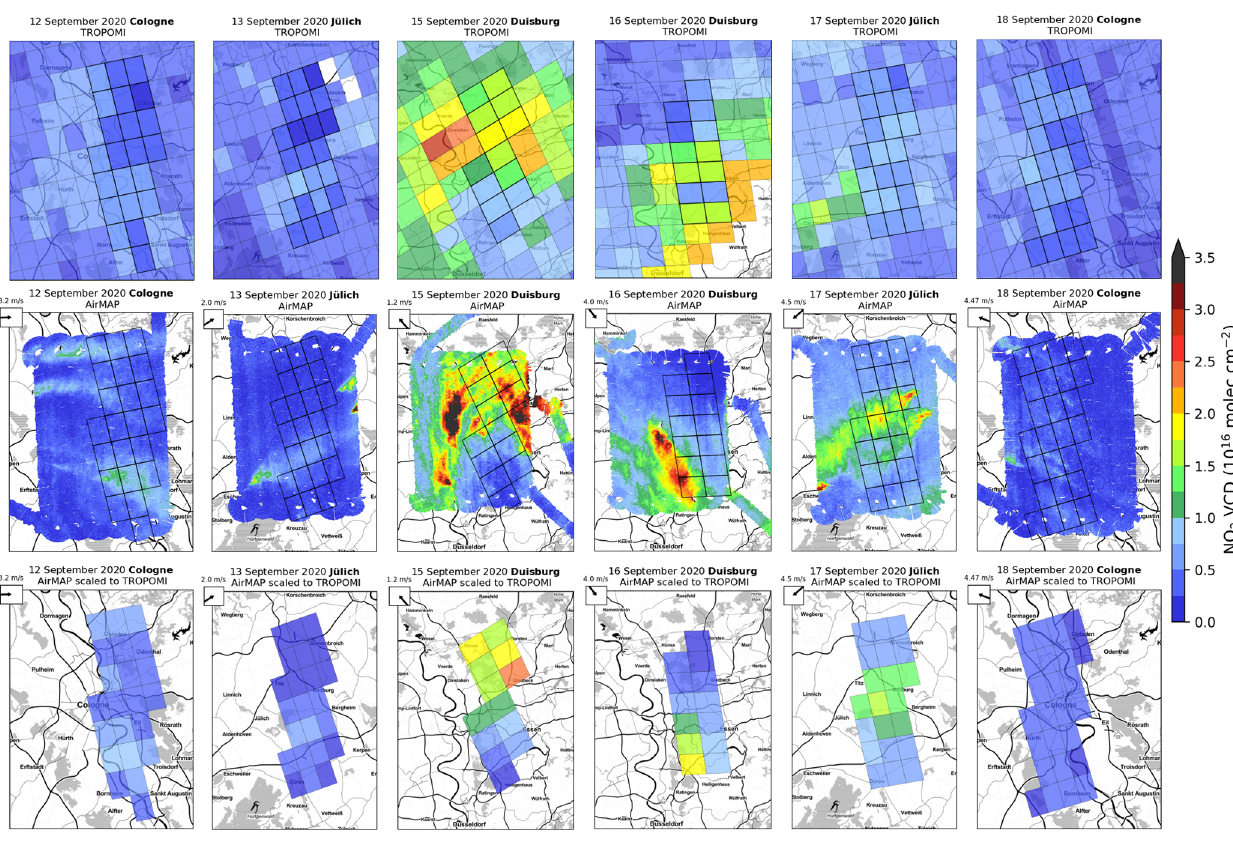
Figure 8. Daily maps of tropospheric NO 2 VCDs demonstrating how AirMAP data are matched to TROPOMI measurements. (top row) TROPOMI PAL V02.03.01 tropospheric NO 2 VCDs where qa_value > 0.75. (middle row) AirMAP tropospheric NO 2 VCDs with overlaid TROPOMI pixel outlines that fulfill the co-location criteria of a coverage of at least 75% and AirMAP measurements ± 30min around the